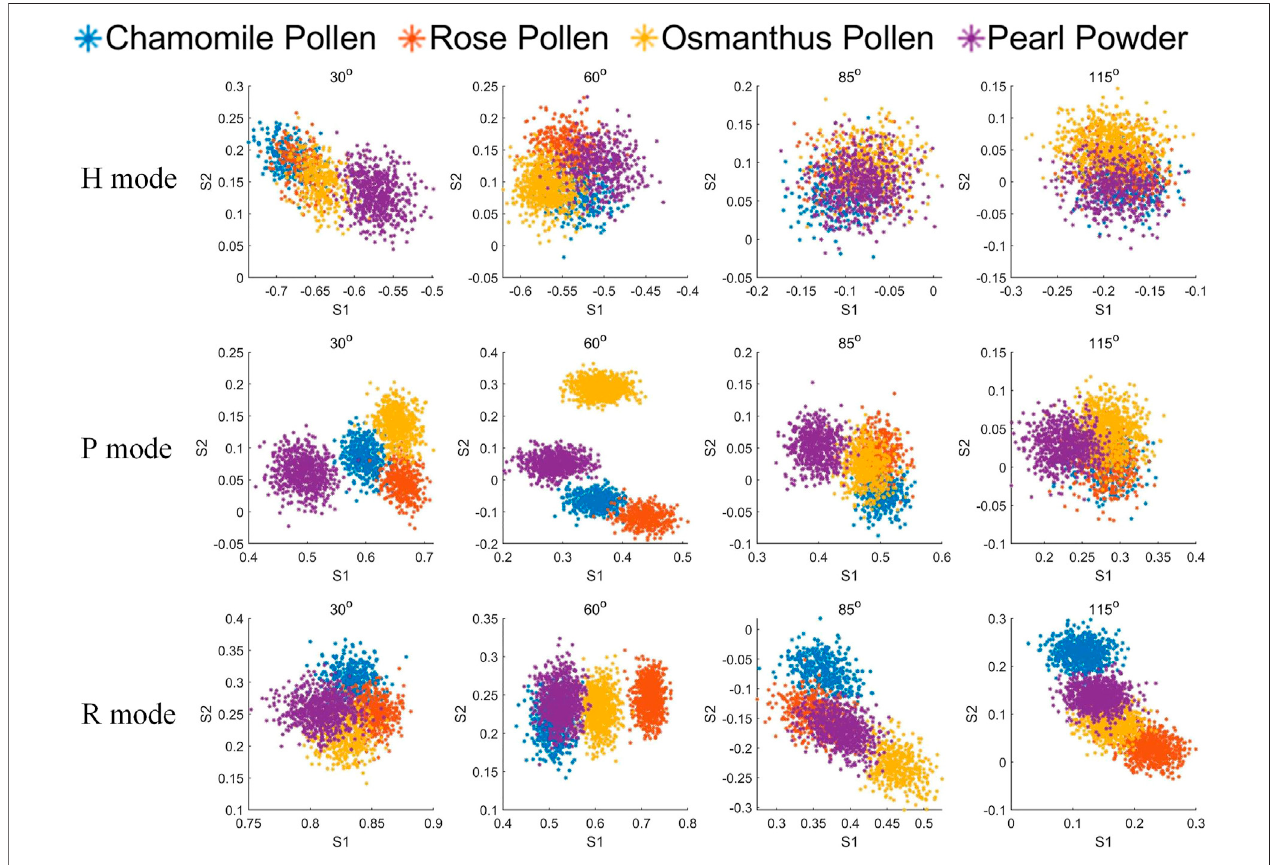
FIGURE 5 | Biological samples under the multi-angle polarization index system